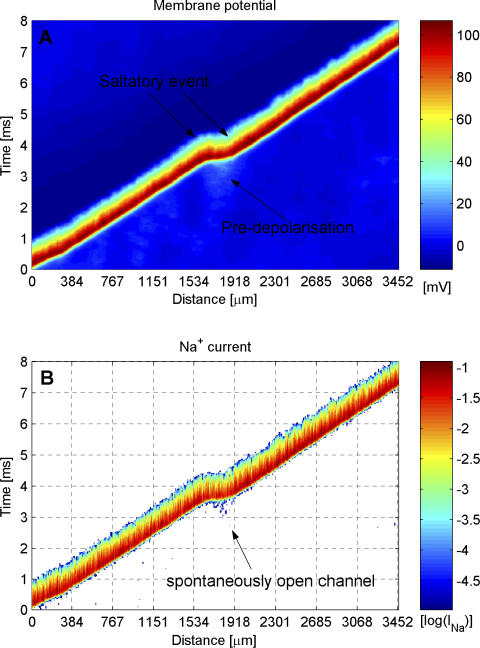
Visualization of a Stochastic Microsaltatory Conduction Event in a 0.1 μm Diameter Squid AxonA continuously propagating AP wavefront (note the jitter in propagation speed) suddenly jumps from position x = 1,550 μm to x = 1,900 μm. Displays a space-time plot of the membrane potential on the axon (A) and the corresponding space time plot of the transmembrane Na current (B). The regions where no Na current was flowing are white, making ionic currents from spontaneously open channels clearly visible.